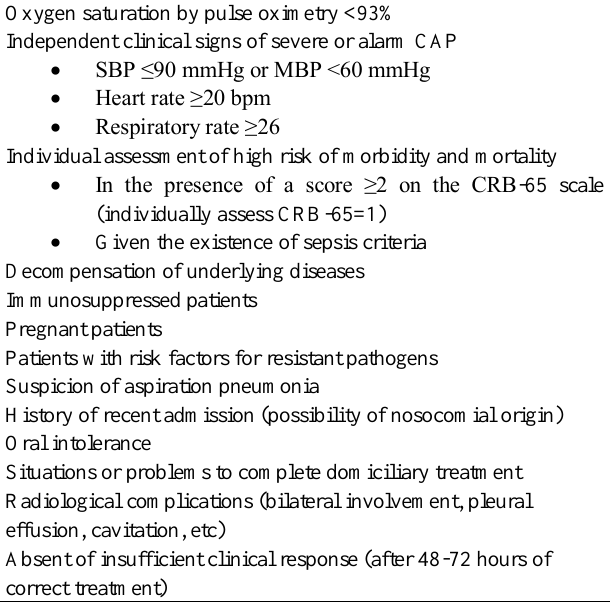
Table 3: CAP: Community acquired pneumonia; SBP: Systolic blood pressure; mbp: Medium blood pressure: bpm: Beats per minute; CRB-65: acronym for confusion, respiratory rate ≥30,